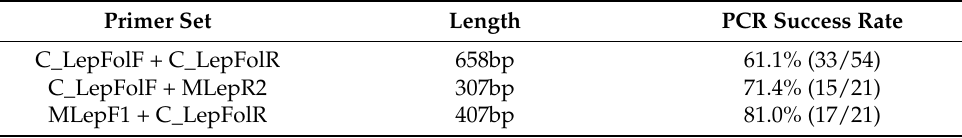
Table 2. Primer sets used to amplify COI barcode sequences of Entiminae.